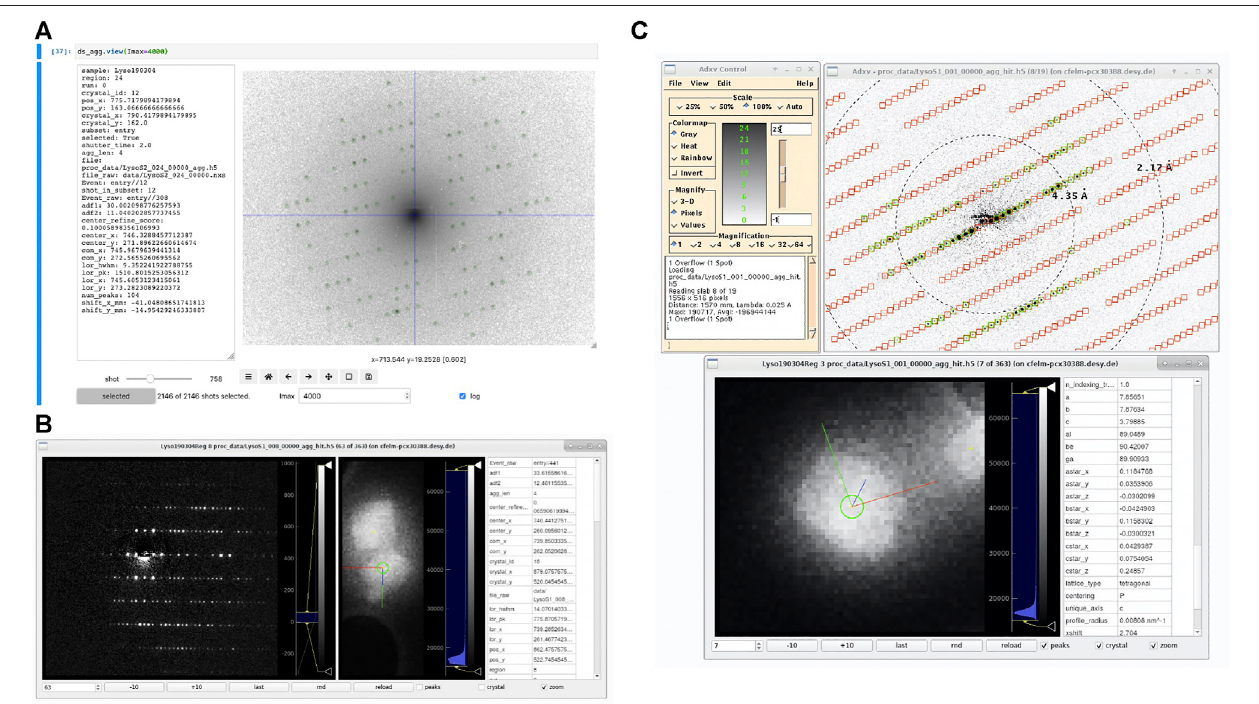
FIGURE 9 | Screenshots of diffraction viewing tools of diffractem . (A) Dataset. view running as an interactive widget inside a Jupyter notebook in a web browser. The diffraction pattern is shown on logarithmic scale, which is particularly useful to assess the quality of pattern center and peak fi nding at low resolutions; the pattern center and Bragg peaks are shown as blue cross-hair and green circles, respectively. On the left, data from the shot table for the shown pattern are displayed. The controls at the bottom allow to move between shots and set display parameters (B) edview running in internal-viewer mode. In three columns, the diffraction pattern, the map image (optionally zoomed into the shown crystal) and meta-data from the shot table and the indexing result from a. stream fi le for the shown diffraction pattern are shown, respectively. Image controls are at the bottom. (C) edview in external-viewer mode, in which the diffraction pattern is displayed through adxv (Arvai, 2020). In the pattern, found peaks (green circles) and predicted Bragg spot positions from the indexing solution (red squares) are shown. In the bottom edview window, → → → , b , c the corresponding crystal is shown. The directions of the real-space lattice vectors a are shown in red, green, and blue,